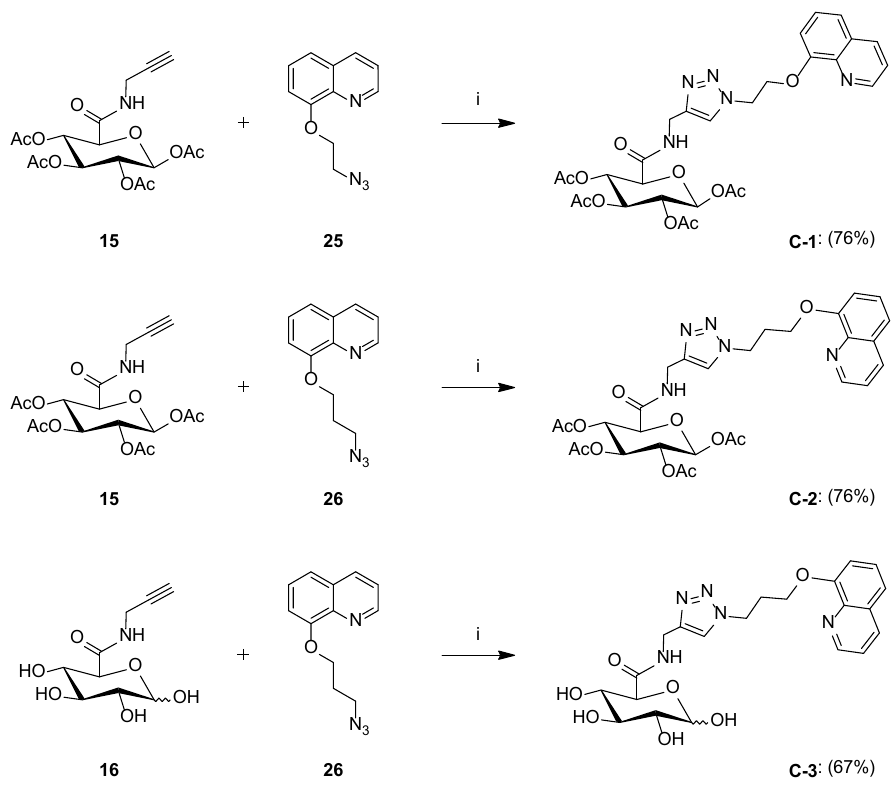
Scheme 7. Synthesis of type C glycoconjugates. Reagents and Conditions: ( i ) CuSO 4 · 5H 2 O, NaAsc, i -PrOH/THF/H 2 O (1:1:1, v : v : v ), r.t., 24 h.